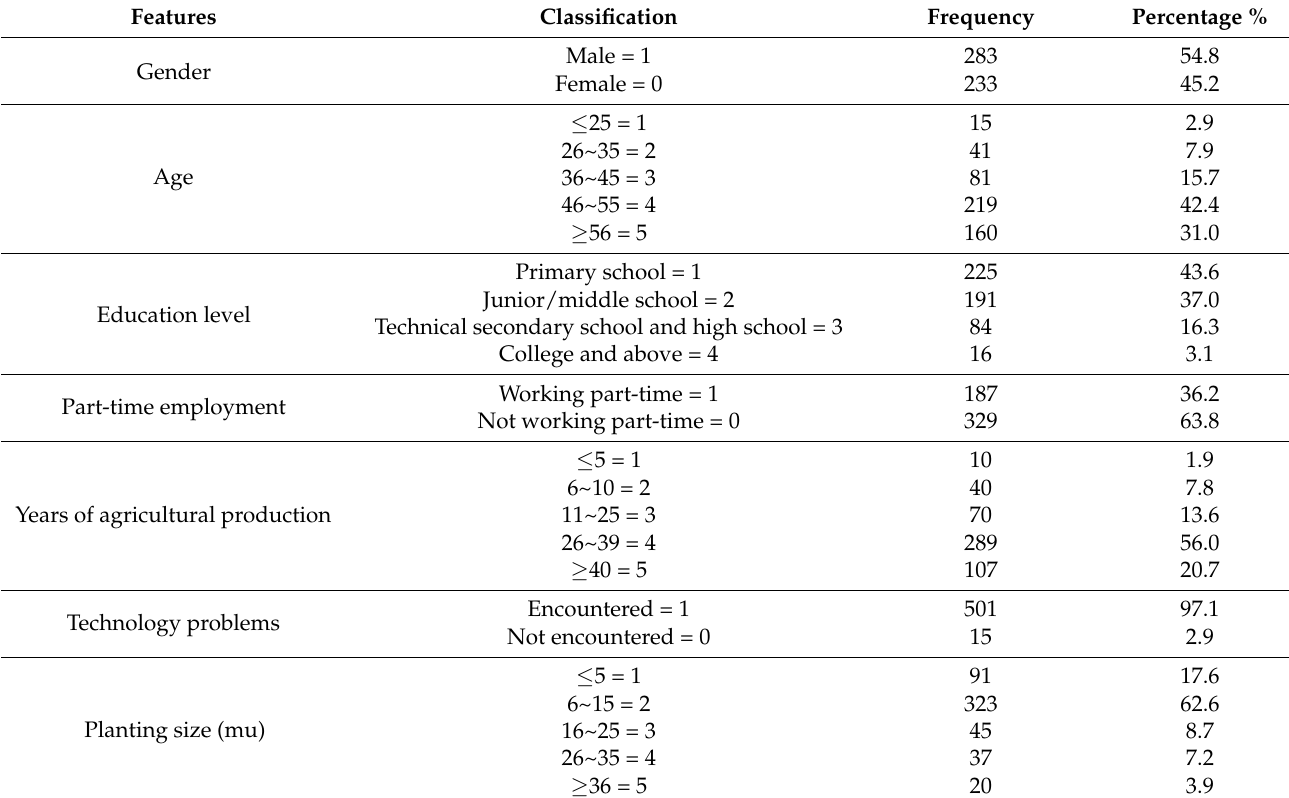
Table 1. Basic characteristics of sample farmers.